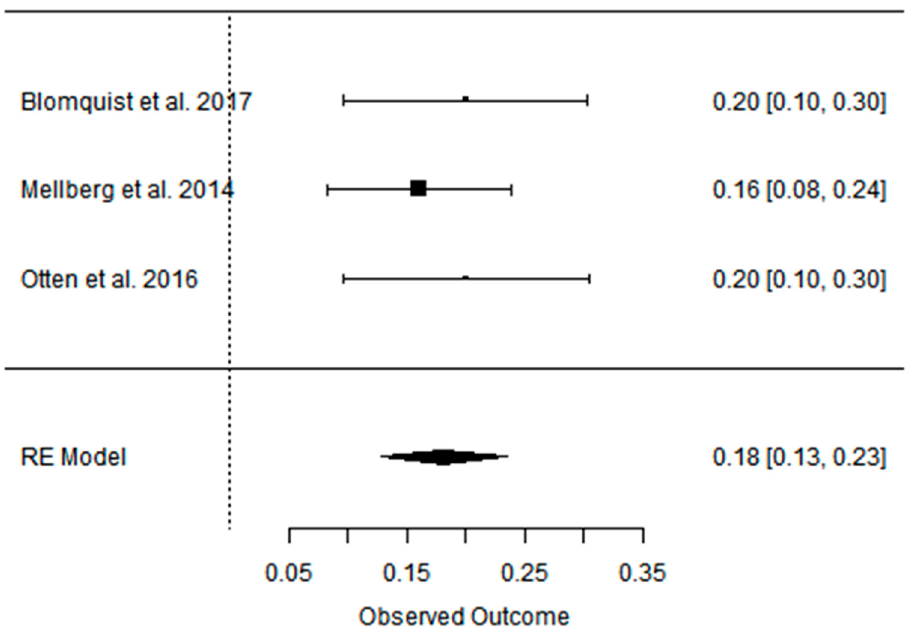
Figure A30. Forest plot of the effect of a PD on HDL-C in the long term (weighted mean difference).